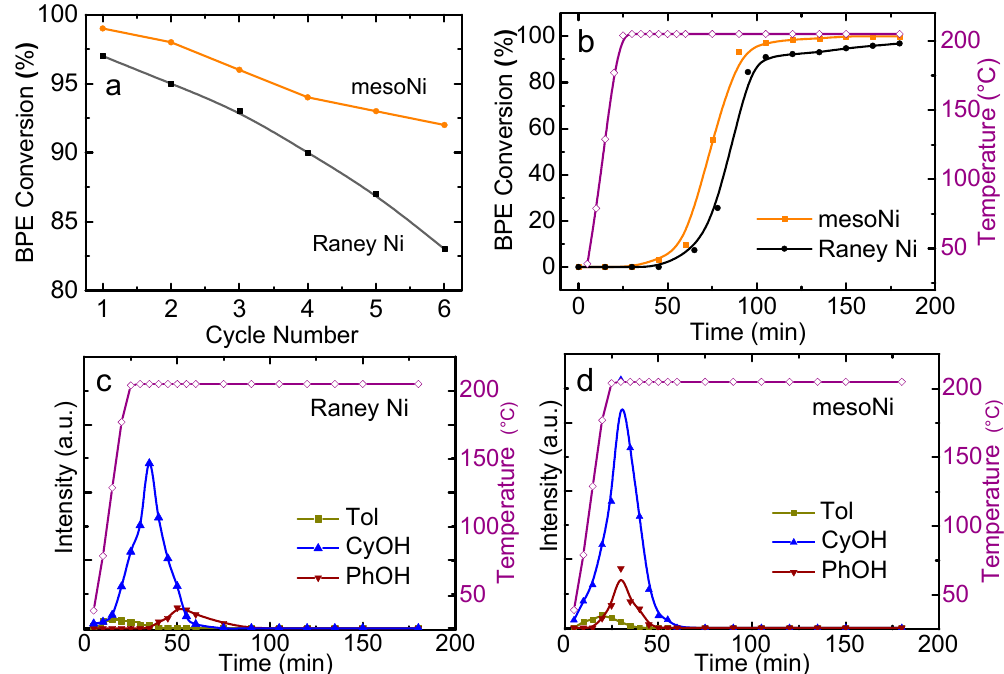
Figure 3. ( a ) Recycling of mesoNi and Raney Ni catalysts used in batch benzyl phenyl ether (BPE) hydrogenolysis. Reaction conditions: 120 ◦ C, 20.0 mg catalyst, 80 mL 2-propanol (2-PrOH) as both solvent and H-donor, pressure 4 MPa, 5.0 mmol · L − 1 BPE, stirring at 650 rpm. ( b ) Temperature-programmed regeneration of the used mesoNi and Raney Ni catalysts in a flow reactor. Regeneration conditions: 25–205 ◦ C, 10 ◦ C · min − 1 , 20.0 mg catalyst, 2-PrOH as both